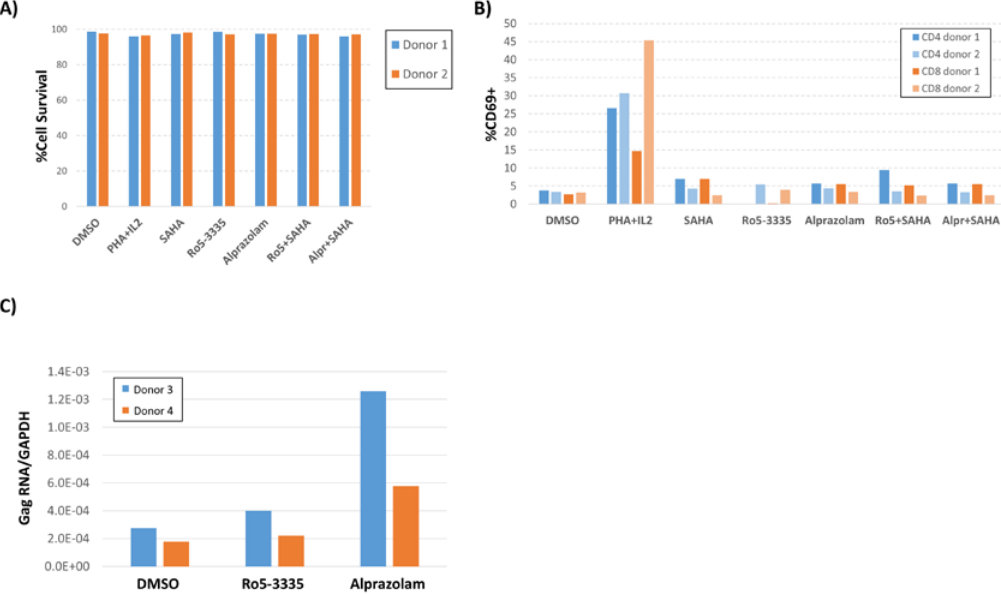
Figure 5. Effect of Ro5-3335 or Alprazolam on viability and HIV-1 transcription in PBMCs. Peripheral blood monocytes (PBMC) from two healthy donors were treated with 10 µM of Alprazolam or 50 µM of Ro5-3335 alone or in combination with 0.5 µM SAHA. 24 h post treatment, cells were stained with Zombie Yellow Live/Dead staining and then stained for CD3, CD4, CD8, and CD69. Then, cells were fixed for flow cytometry. ( A ) Percentage of live PBMCs after each treatment. ( B ) T-cell activation was graphed as the percentage of CD3+/CD4+ or CD3+/CD8+ cells that were CD69 + . ( C ) PBMC from two HIV-1 positive subjects that were suppressed on antiretroviral therapy (ART) for more than 6 months were treated with Alprazolam or Ro5-3335 for 48 h. RNA was extracted using Trizol and cDNA was synthesized by RT reaction. qPCR was done to determine the relative increase in HIV-1 Gag mRNA as normalized to GAPDH. Panels A, B and C show the individual data from two human subjects.